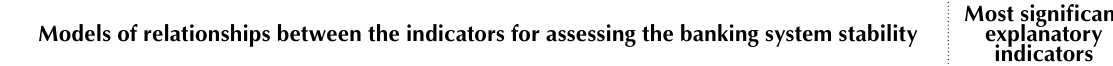
) and structural changes and financial 9